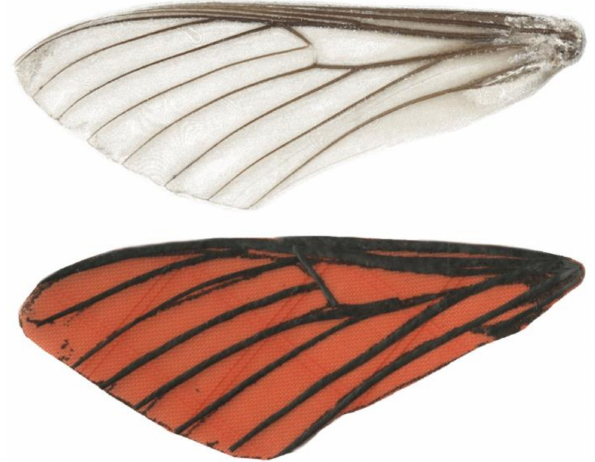
Figure 1. ( top ) 2D scan of natural forewing excised from Manduca sexta ( bottom ). Artificial forewing used in this study. These manufactured wings have an approximate wing length of 50 mm, chord length of 20 mm, and mass of 40 mg. Their membrane is made of Icarex ™ ripstop polyester, and their venation structure is constructed of Gurit prepreg unidirectional carbon fiber